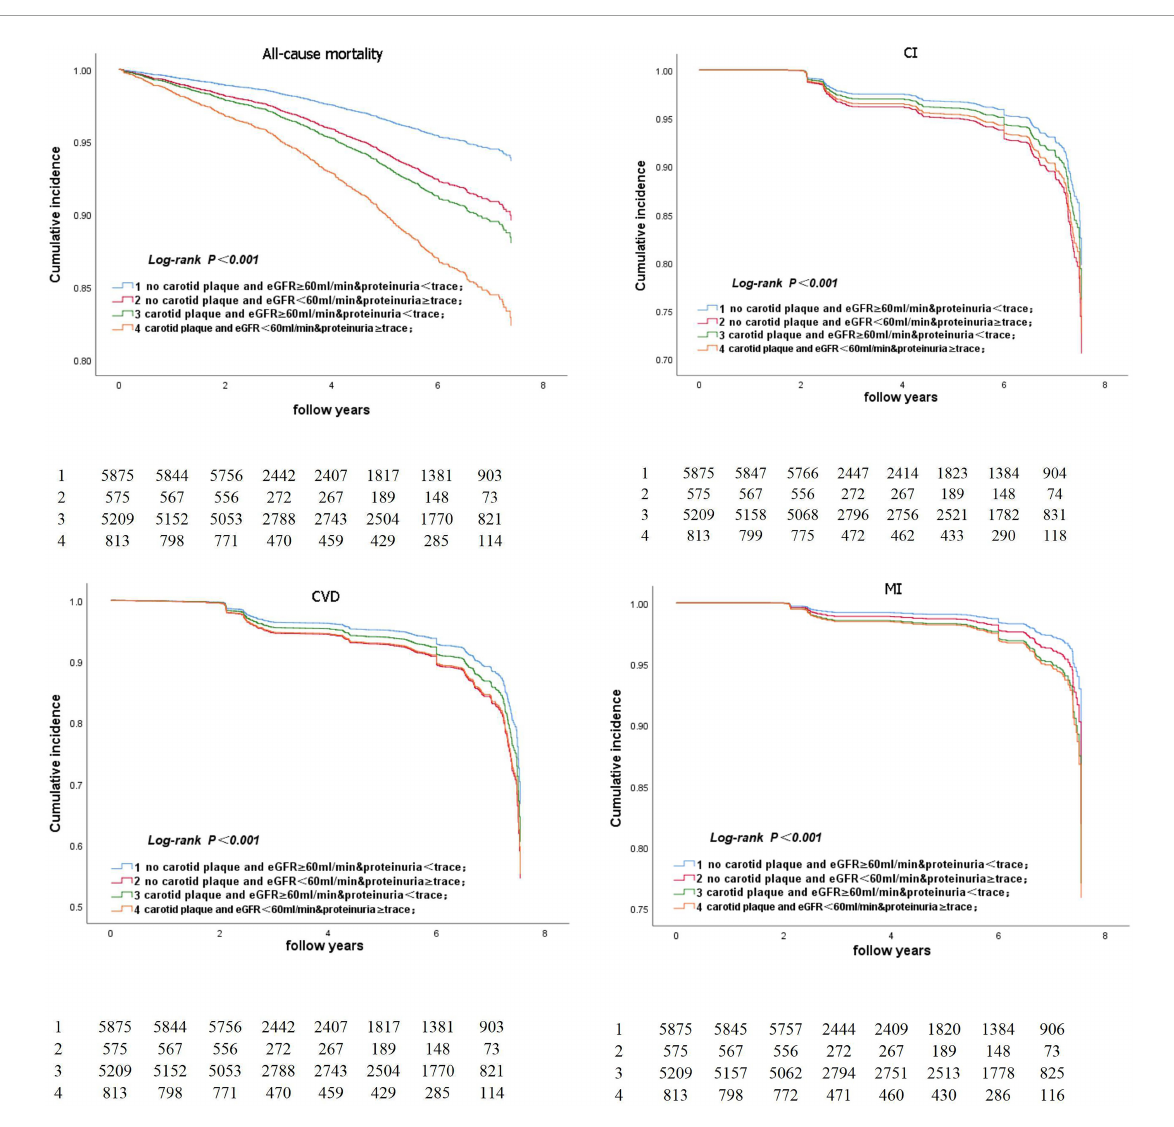
FIGURE6 Kaplan-Meier survival curve for all-cause death and CVD event in participants aged ≥ 50